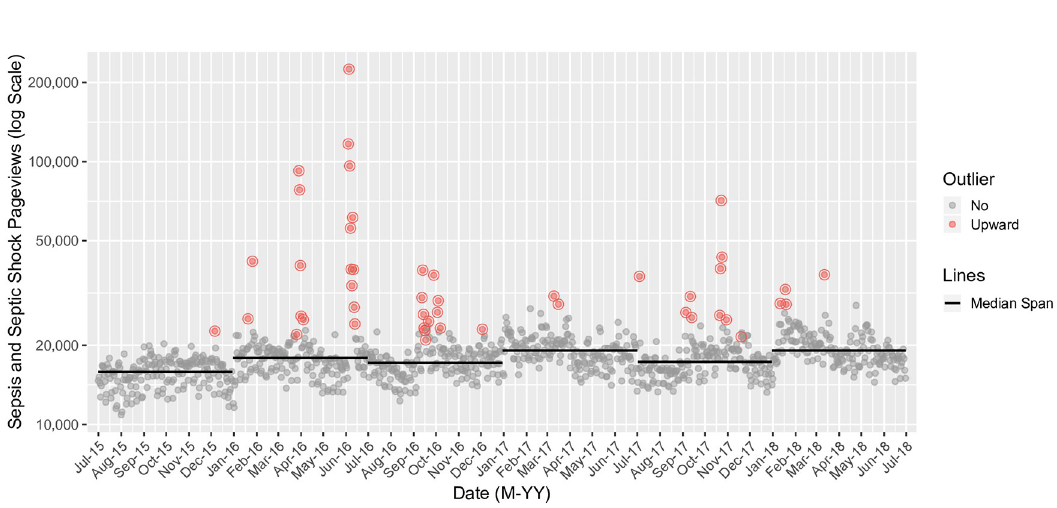
Fig 3. Sepsis and septic shock user pageview traffic (2015 to 2018). Data extraction spanned July 1, 2015 to June 30, 2018. Outliers with observed values significantly (alpha = 0.01) exceeding those expected are highlighted. Outliers with observed values significantly below those expected were not sought and are not depicted. Median spans are displayed as horizontal black lines (see Methods). The Y axis employs a log scale to improve legibility in the setting of large outliers within the time series. Suggested correlates for outlying values are presented in Table 1. Pageviews across all available languages are depicted in the figure.